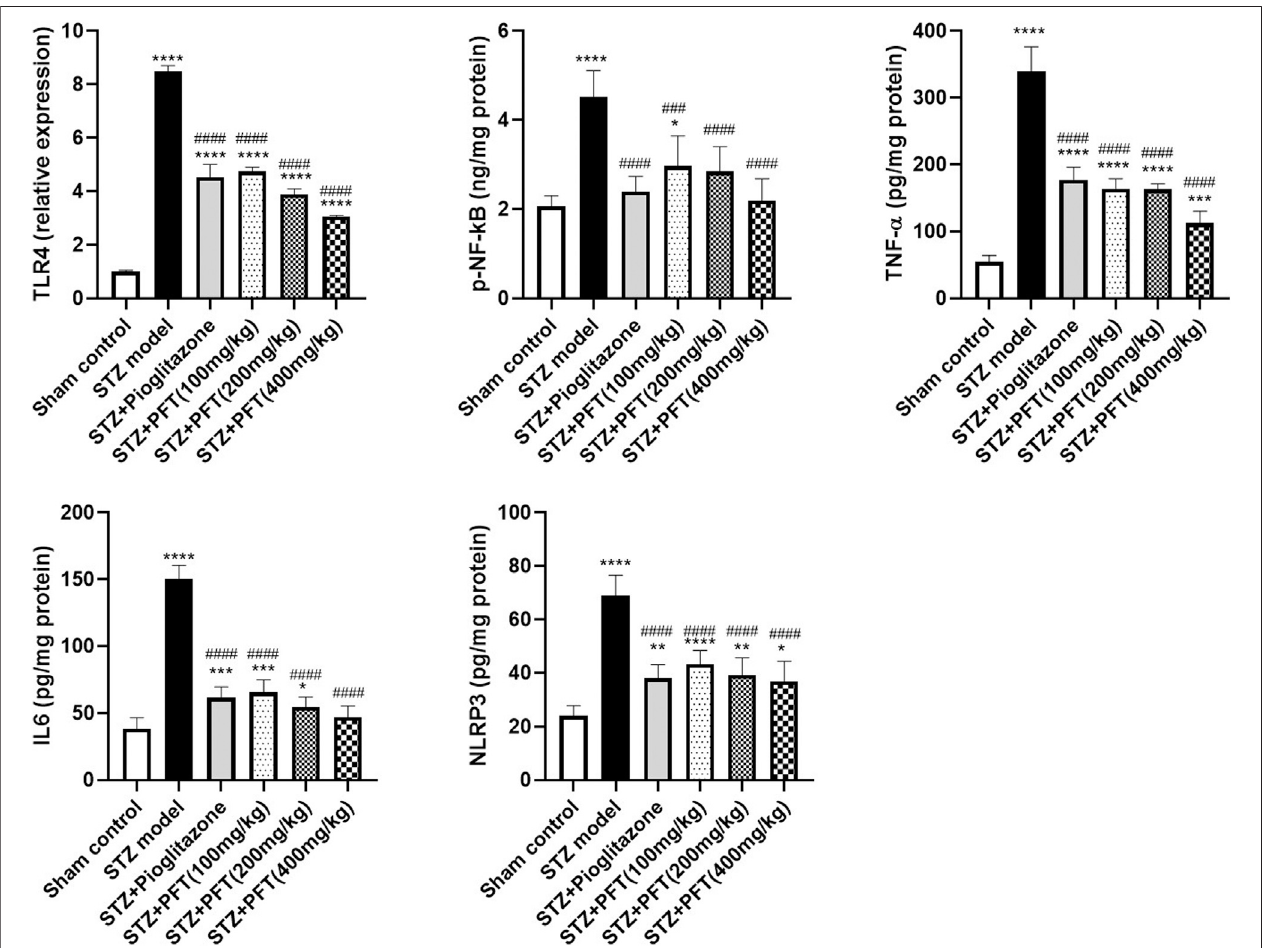
FIGURE 6 | PFT alleviatedSTZ-induced in fl ammatorychanges.Eachbarwithvertical linerepresentsthe mean ± SDofthree mice pergroup for TLR4 and ofsix mice pergroupforp-NF-kB,TNF- α ,IL6,andNLRP3;*signi fi cantlydifferentfromtheshamcontrolgroupat p < 0.05, ** signi fi cantlydifferentfromtheshamcontrolgroupat p < 0.01, *** signi fi cantly different from the sham control group at p < 0.001, **** signi fi cantly different from the sham control group at p < 0.0001, ### signi fi cantly different from the STZ group at p < 0.001, #### signi fi cantly different from the STZ group at p < 0.0001 using One-Way ANOVA followed by Tukey ’ s multiple comparisons test.